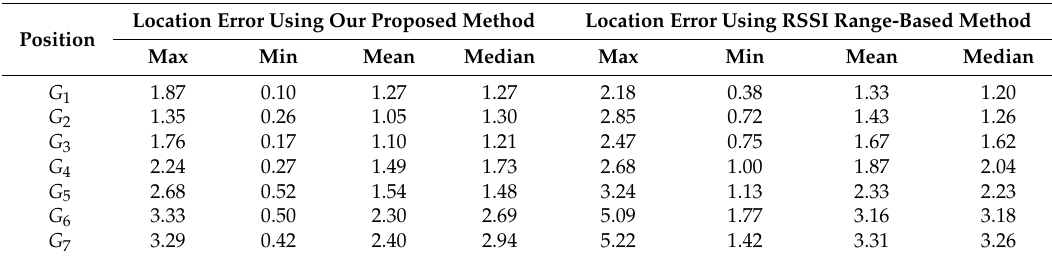
Figure 9. Indoor localization errors using the received signal strength indication (RSSI) range-based method. Table 2. Indoor localization